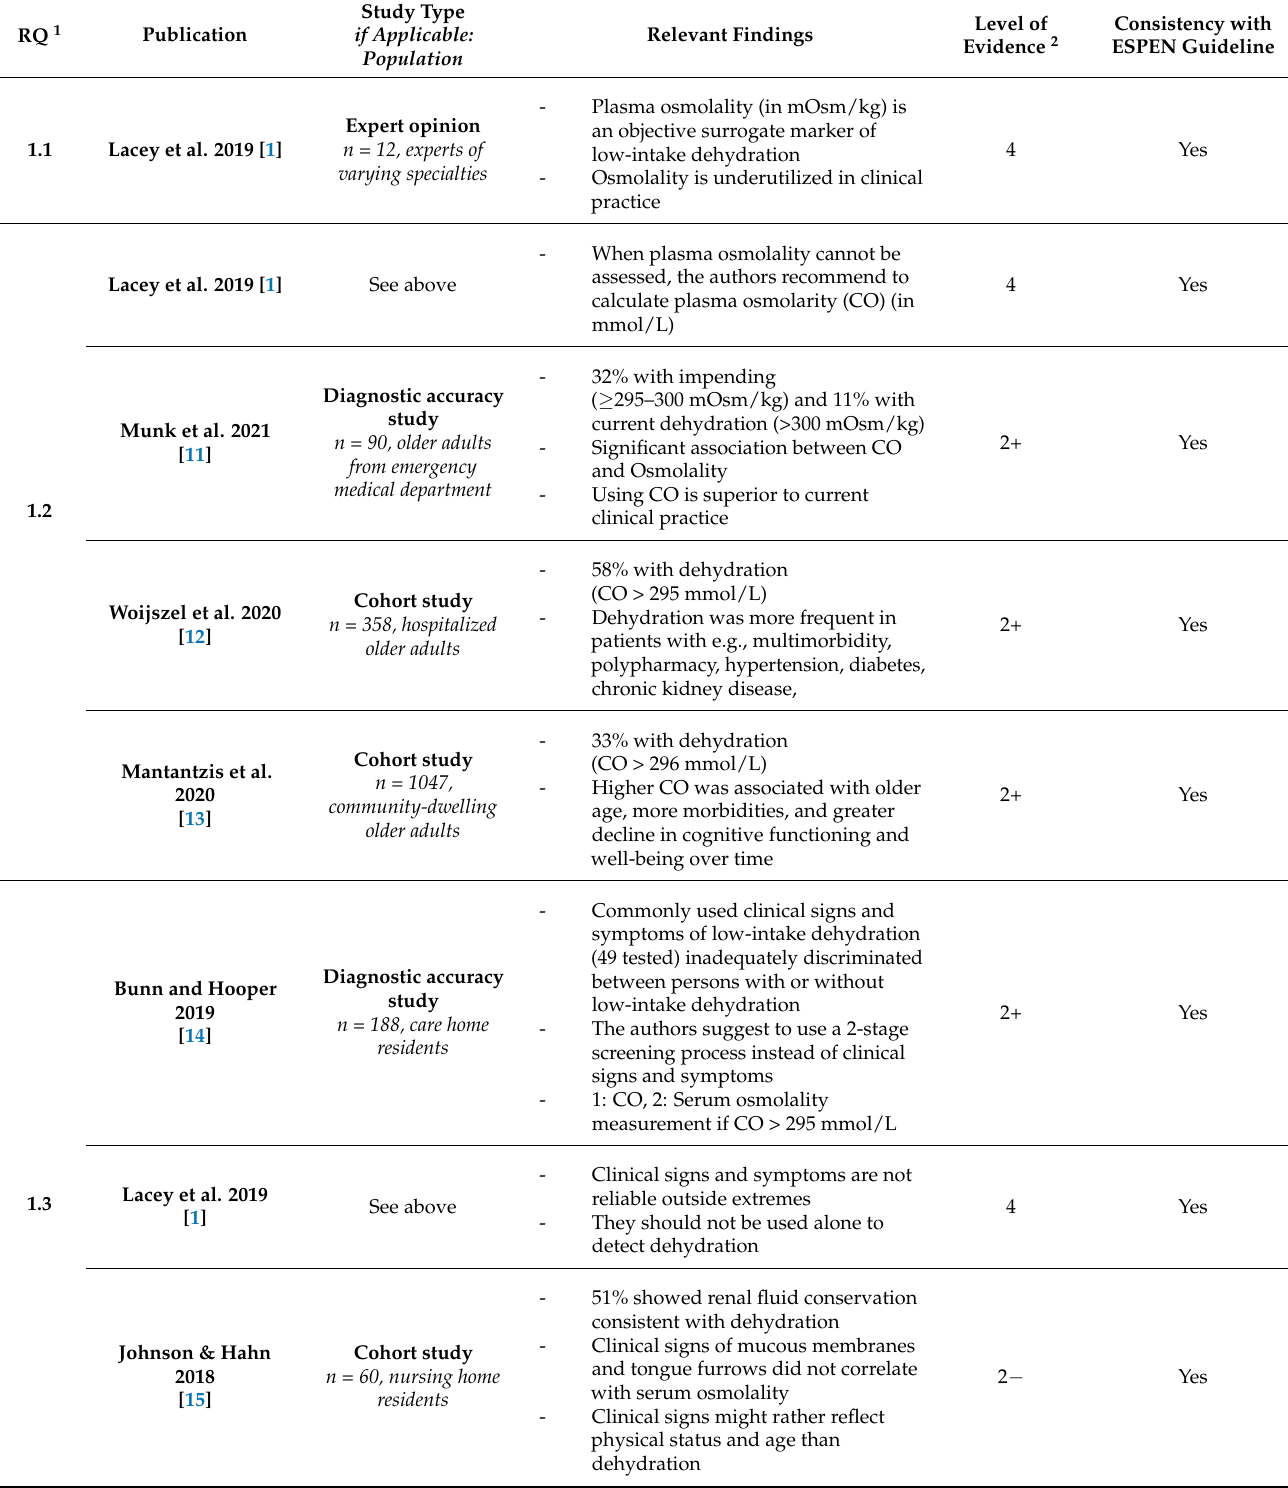
Table 2. Characteristics of included